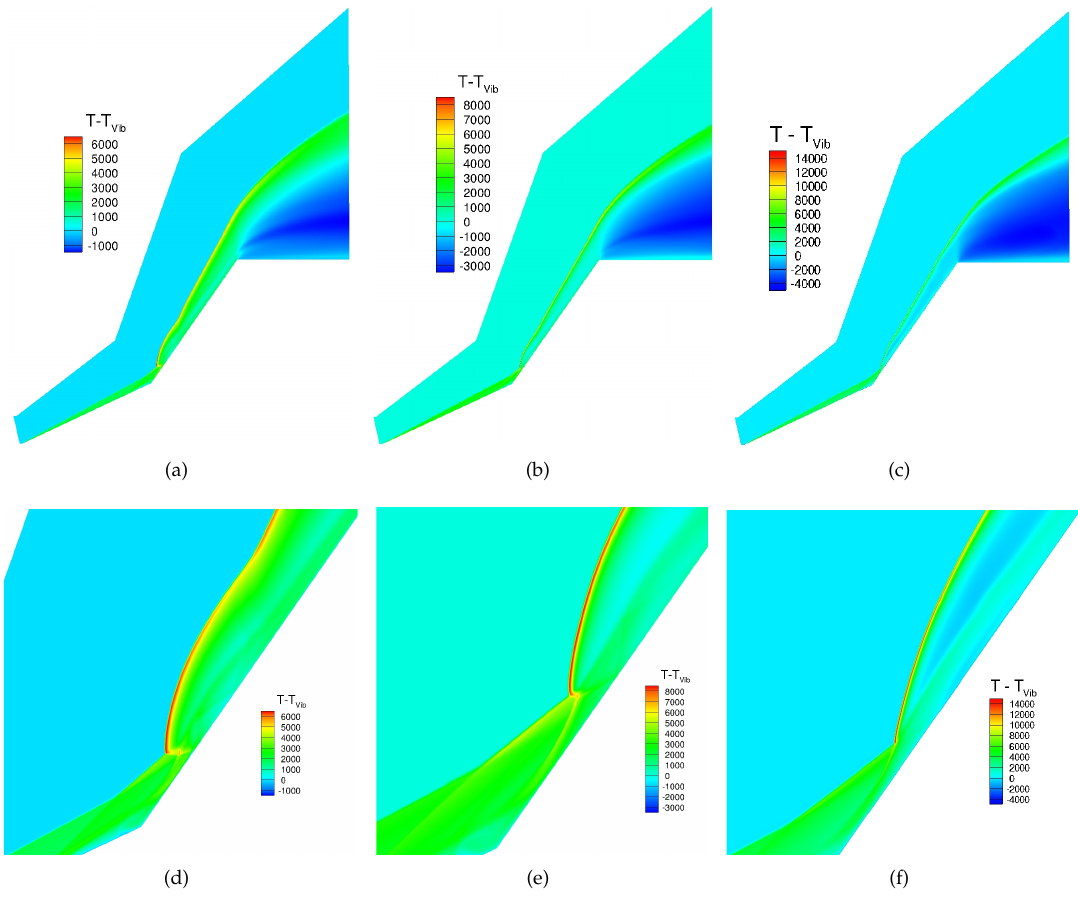
Figure 14. T − T Vib . ( a ) T − T Vib Run 2; ( b ) T − T Vib Run 6; ( c ) T − T Vib Run 4; ( d ) T − T Vib Run 2 enlargement; ( e ) T − T Vib Run 6 enlargement; ( f ) T − T Vib Run 4